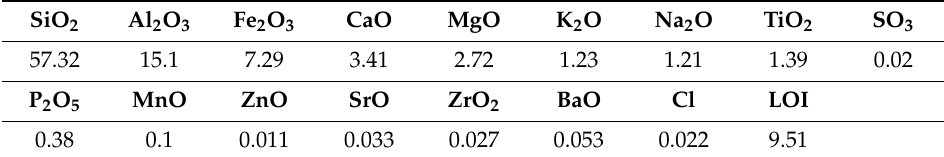
Table 3. The chemical composition of bentonite